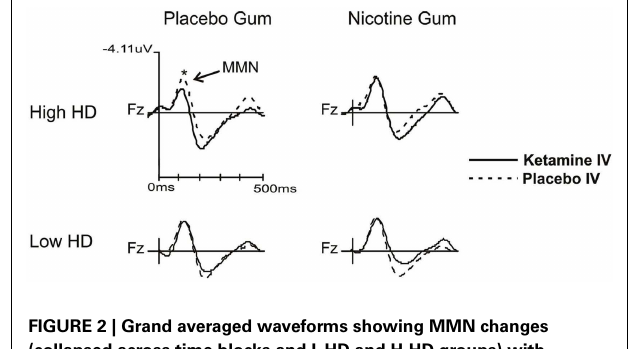
FIGURE 2 | Grand averaged waveforms showing MMN changes (collapsed across time blocks and L-HD and H-HD groups) with ketamine and placebo infusions when combined with nicotine and placebo gum (* p < 0.05).